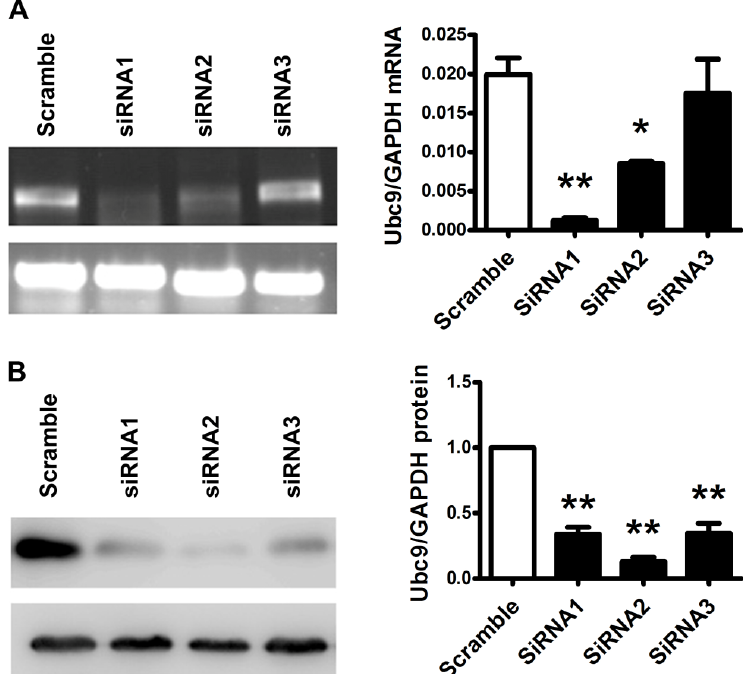
Figure 3. Identification of Ubc9 siRNA. ( A ) Identification of Ubc9 siRNA by real-time PCR. Relative mRNA levels were normalized to that with scramble siRNA treatment; ( B ) Ubc9 protein level in HO8910-Ubc9 cells treated with Ubc9 siRNA. The right panel represents the summary results of Ubc9 protein level. Relative protein levels were normalized to that with scramble siRNA treatment. Data are mean ± SEM from 3 separate experiments. * p < 0.05, ** p < 0.01 versus scramble